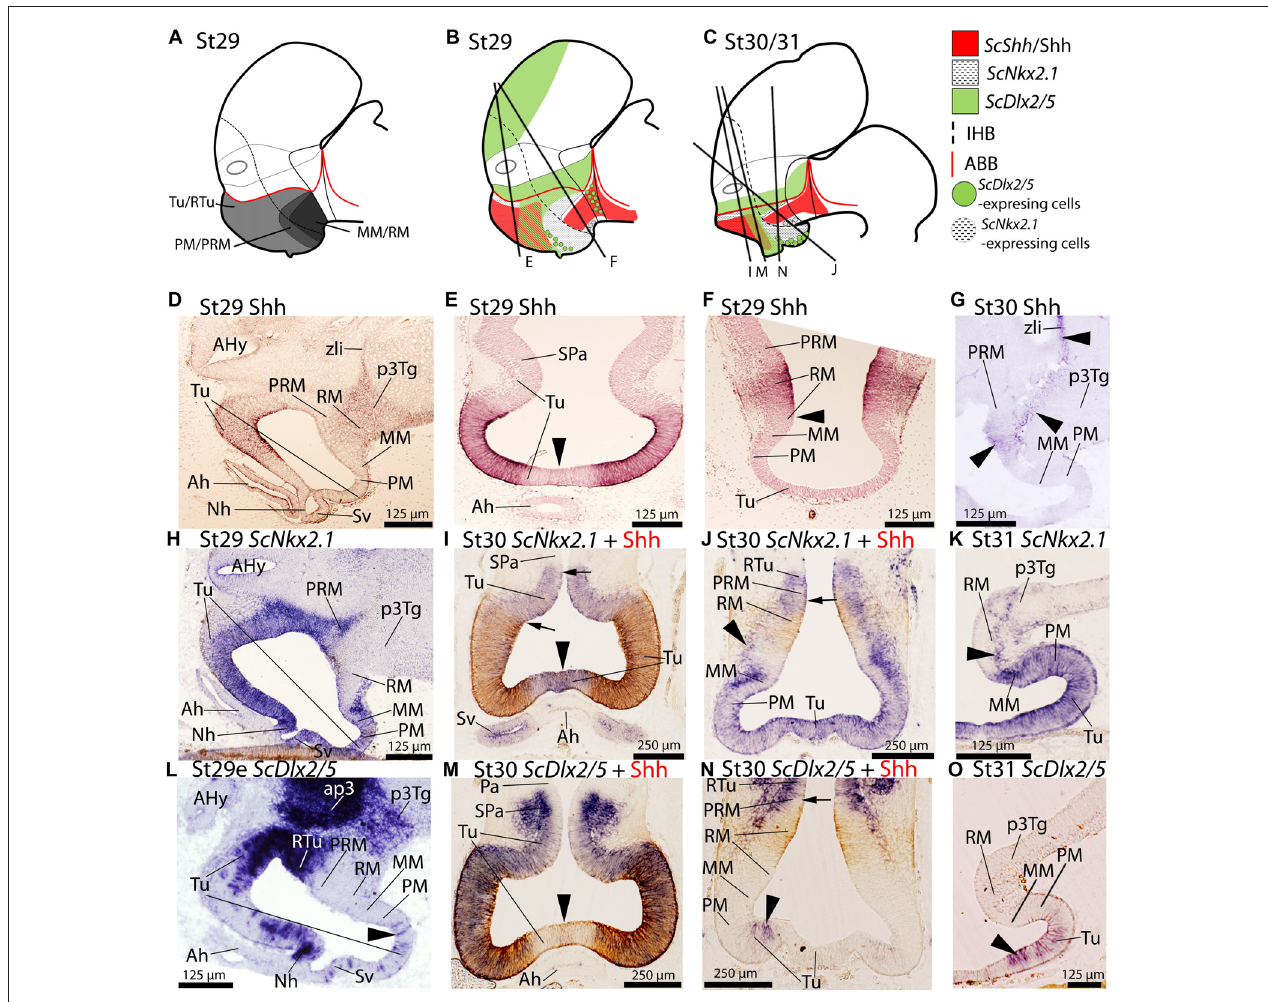
FIGURE 1 | Regionalization of the basal hypothalamus and neighbor territories in embryos of S. canicula at stages 29–31. Sagittal schemes (A–C) and sections showing immunoreactivity to Shh (D–G) , and expression of ScNkx2.1 (H–K) , and ScDlx2/5 (L–O) by means of immunohistochemistry (IHC) (D–G) , and in situ hybridization (H–O) on sagittal (D,G,H,K,L,O) or transverse (E,F,I,J,M,N) sections. Some in situ sections were double labeled for IHC against Shh (I,J,M,N) . (A–C) Schemes of basal hypothalamus compartments at parasagittal levels at stage 29 and stage 30/31. For simplicity, the schemes do not represent medial (acroterminal) expression patterns. (A) Shark basal hypothalamic compartments at stage 29 as defined in Santos-Durán et al. (2015). (B,C) Expression patterns of ScShh/Shh, ScNkx2.1 and ScDlx2/5 at stage 29 and 30/31. (D–G) Shh immunoreactivity in the Tu and RM. Note also the continuity of labeling along the p3Tg and the zona limitans intrathalamica (zli). Black arrowhead in (E) points the lack of labeling in the acroterminal region. Arrowhead in (F) marks the absence of Shh immunoreactivity in the ventral-most portion of RM. Arrowheads in (G) show weak Shh immunoreactivity in RM, p3Tg and zli at stage 30. (H–K) ScNkx2.1 expression is observed in the different territories of the basal hypothalamus excepting the RM. Black arrowhead in (I) points the acroterminal region showing ScNkx2.1 expression and absence of Shh immunoreactivity. Arrows in (I) point differences between the pattern of distribution of Shh immunoreactivity and ScNkx2.1 expression. Arrowheads in (J,K) point ScNkx2.1 -expressing cells in the RM mantle. Arrow in (J) points dorsal-most distribution of Shh immunoreactivity. (L–O) ScDlx2/5 expression in restricted regions of the Tu/RTu. Note also intense labeling in ap3. Arrowheads in (L,N,O) indicate dispersed ScDlx2/5 -expressing cells in the caudo-ventral part of Tu. Arrowhead in (M) marks the acroterminal region lacking ScDlx2/5 expression and Shh immunoreactivity. For abbreviations, see list.